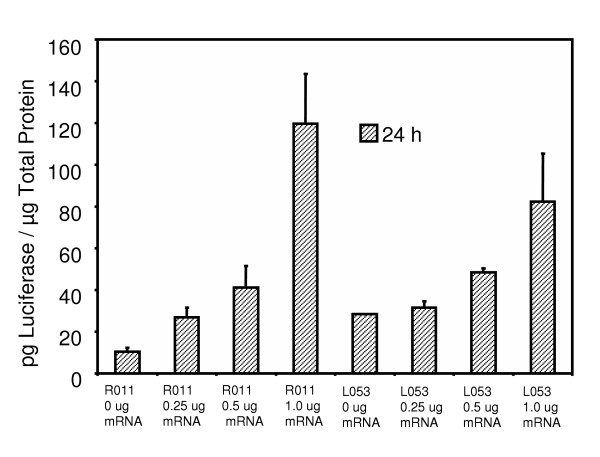
Pretreatment of COS-7 cells with T7 RNAP mRNA. Transfection of COS-7 cells with 0.75 μg of capped T7-RNAP mRNA for 24 hours, followed by a transfection with 0.75 μg of R011 (cytoplasmic) or L053 (nuclear) expression plasmids. Cells were harvested 24 h post plasmid transfection. Transfections and luciferase assays were performed as described in Materials and Methods. Error bars indicate standard error